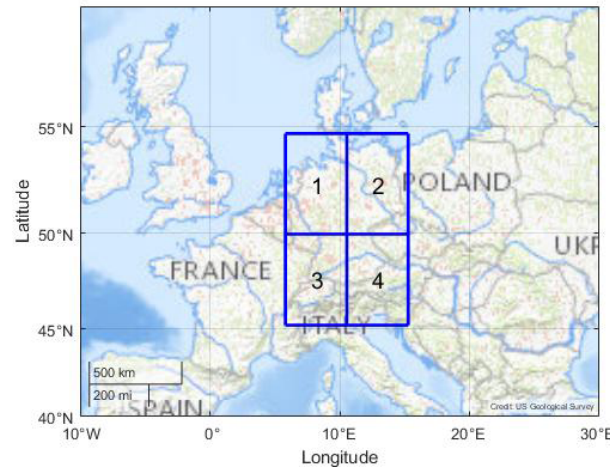
Figure 2. REA6 domain that covers Germany consisting of grid boxes 1 to 4; grid box 1 is applied on the large scale for DBMR and is of approximately 500km × 500km. Image credit of the map: US Geological Survey (USGS). Table 1. Number of grid boxes a m and edge length for box discretization of the atmosphere from the large synoptic scale (1000km) across intermediate scales up to the meso- γ scale with convective activity